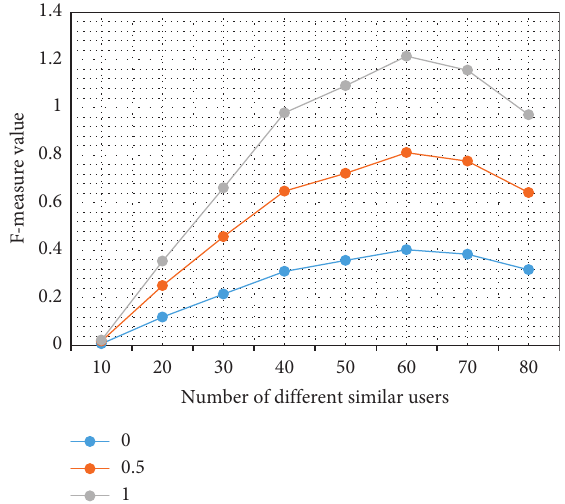
Figure 6: F-measure values under different α values and similar users.